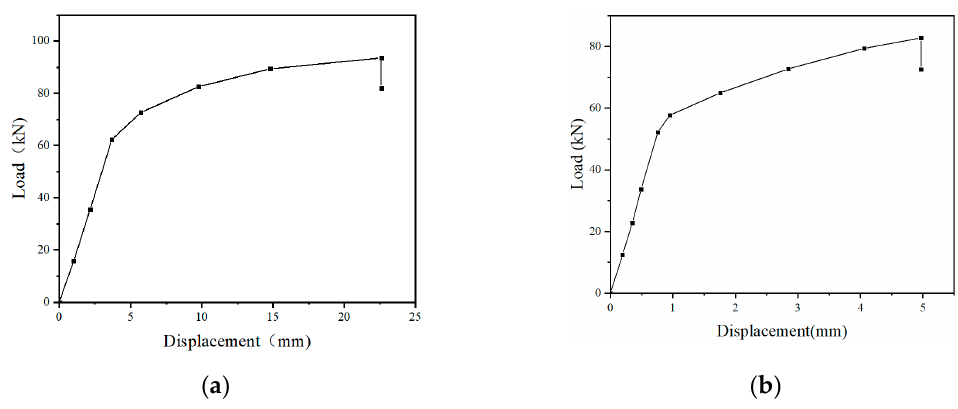
Figure 20. Load–displacement curve of the wall panel. ( a ) Q1 component; ( b ) Q2 component.